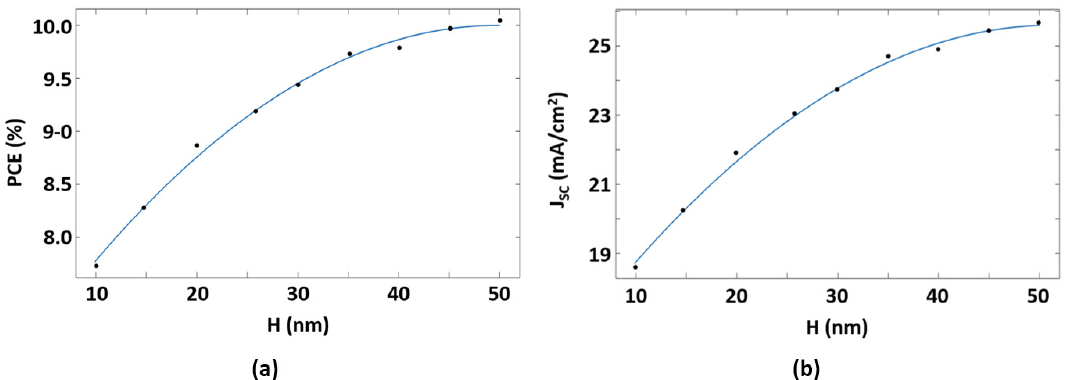
Figure 7. ( a ) PCE dependence on H . ( b ) Short-circuit current density vs. H . Number of atomic layer forming the graphene sheet = 3, solar cell with GO ARC, δ = 1.5 nm, and N D = 10 15 cm − 3 .